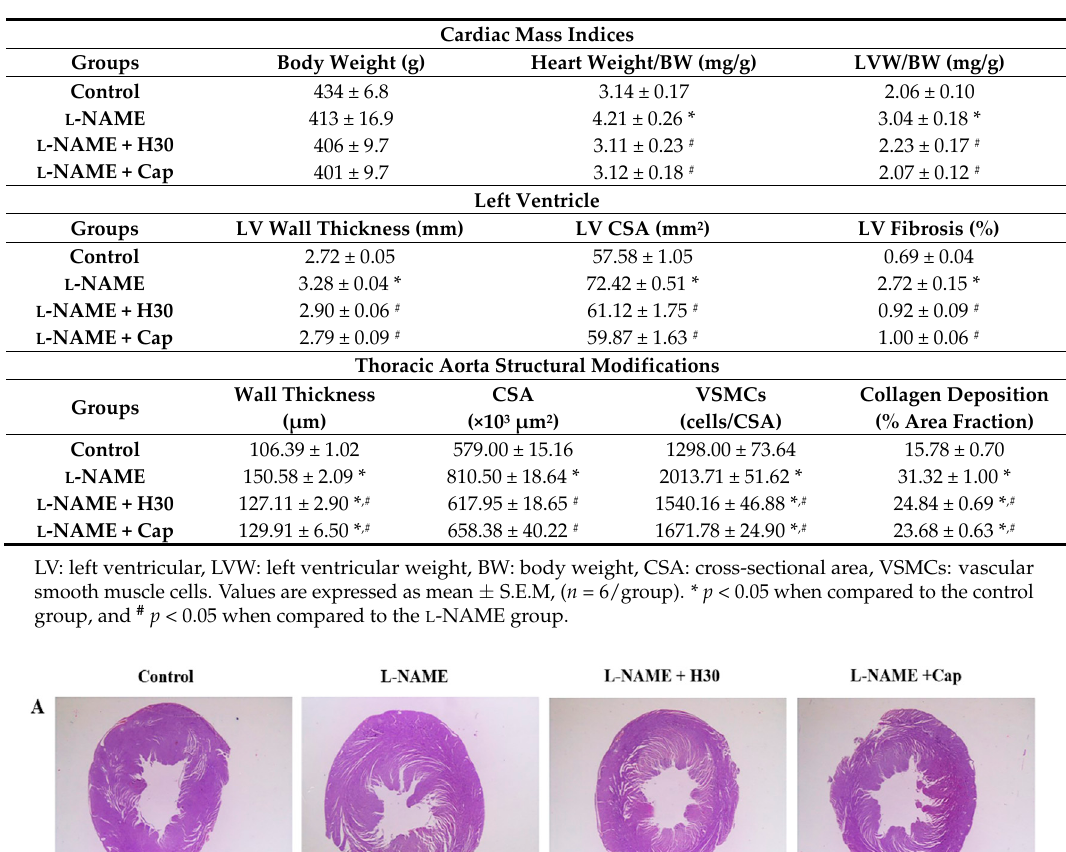
Figure 2. The histology and morphology of LV from control, L -NAME, L -NAME + hesperidin (30 mg/kg) and L -NAME + captopril (2.5 mg/kg) groups. Representative images of LV sections, ( A ) stained with hematoxylin and eosin under stereomicroscopes, and ( B ) stained with picrosirius red under a polarized light microscope using a 20× objective lens. Table 2. Effect of hesperidin and captopril on the cardiac mass indices and cardiovascular structural modifications in left ventricle and thoracic aorta.